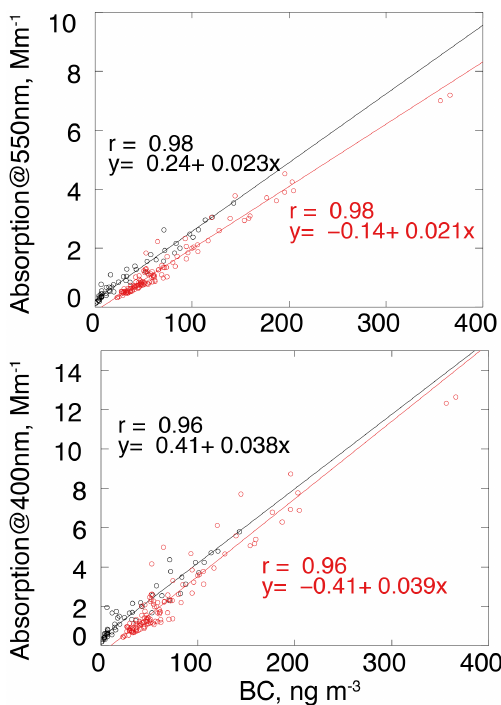
Figure 13. Scatterplot of observed (black) and simulated (red) ab- sorption at 550nm (top) and 400nm (bottom) vs. BC concentrations from at ATTO in January–April 2014. Correlation coefficients and slopes of reduced-major-axis (RMA) regressions are shown as